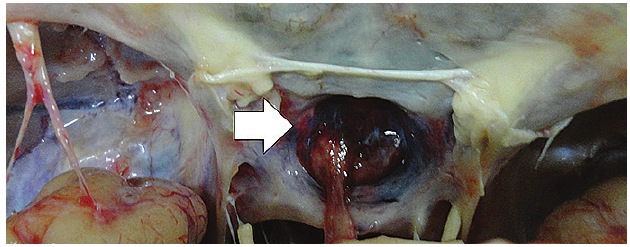
figurE 1 − Enlarged pituitary gland with ecchymoses (arrow)